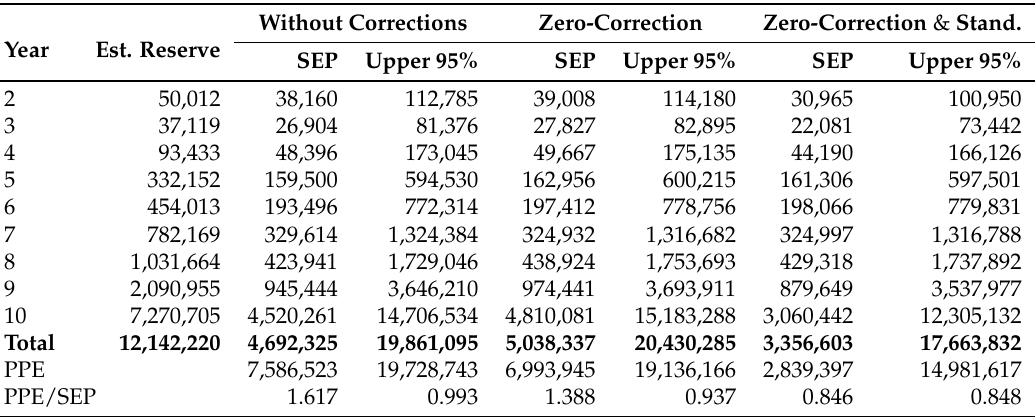
Table 5. Gamma model with Anscombe residuals.